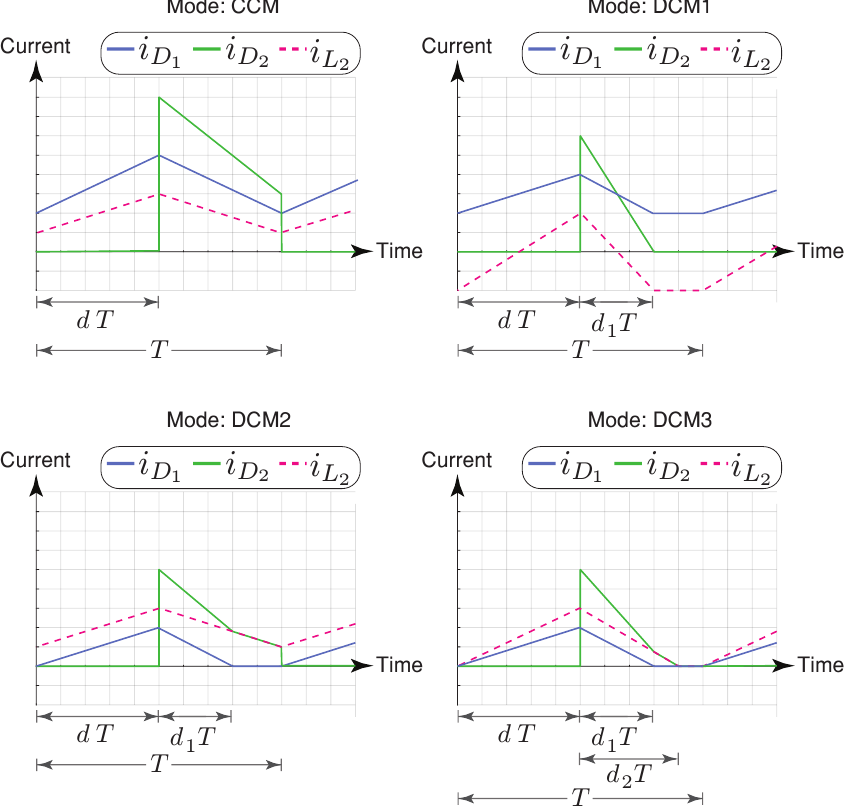
Figure 3. Current waveforms in each conduction